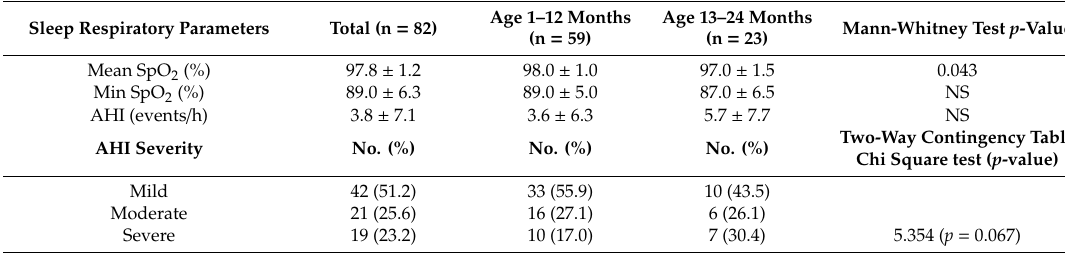
Table 2. Polysomnography findings.